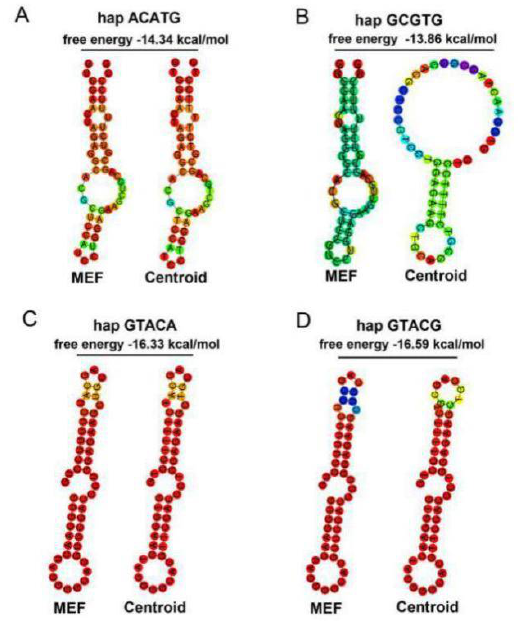
Figure 6. mRNA secondary structure prediction of four haplotypes in PSAP 3’ UTR: ( A ) ACATG; ( B ) GCGTG; ( C ) GTACA; ( D ) GTACG.